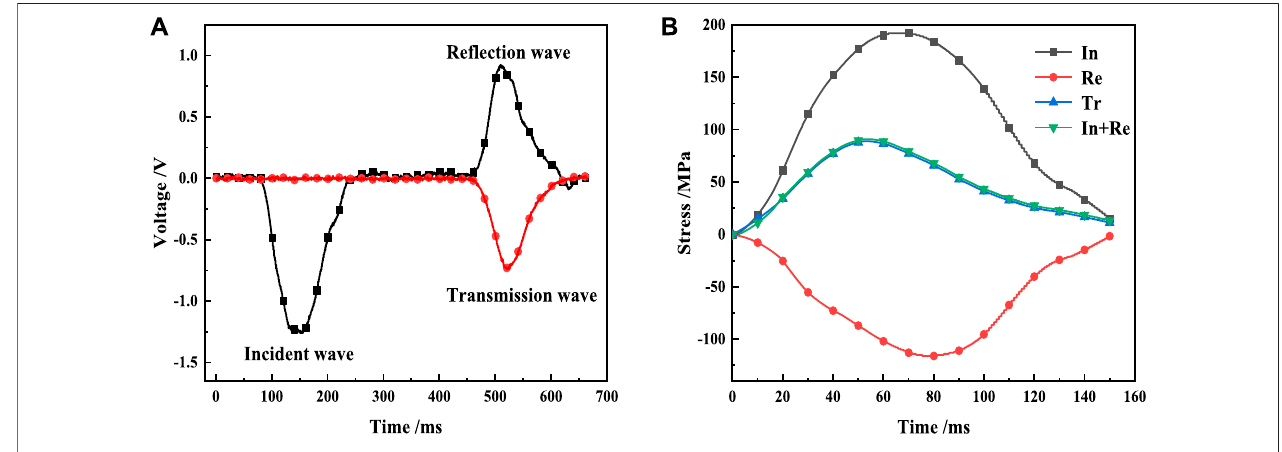
FIGURE 3 | Typical waveforms at both ends of the sample.